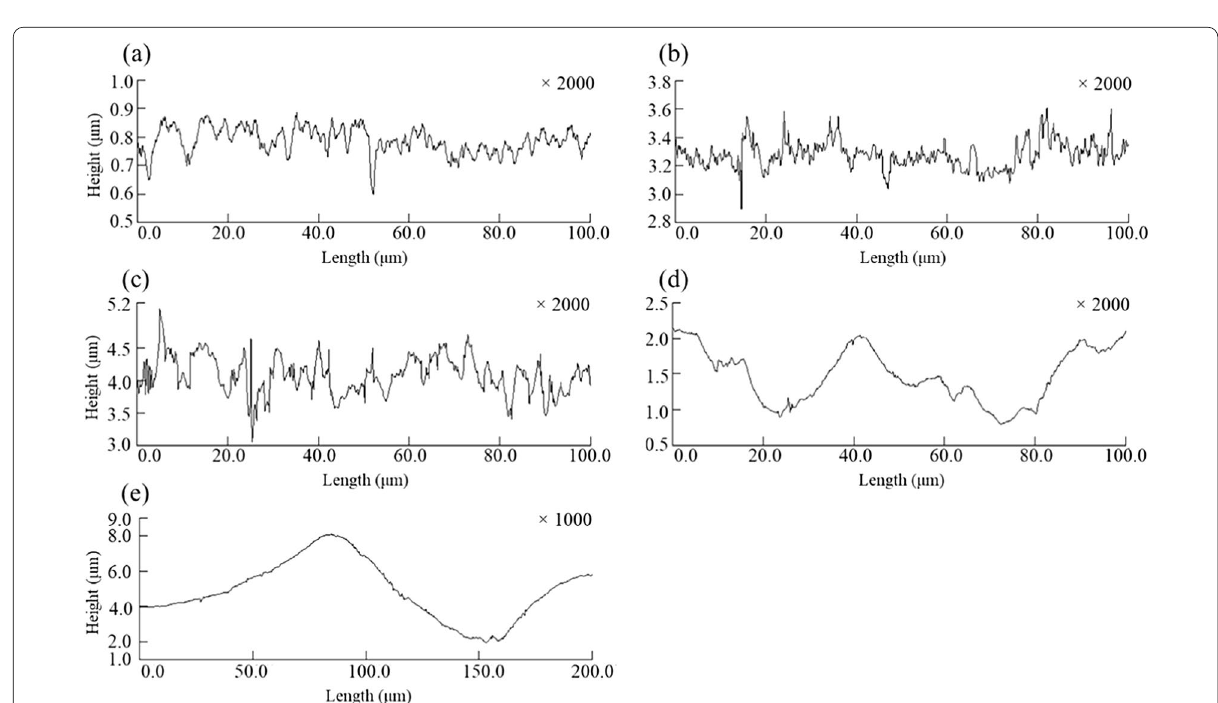
Fig. 2 Cross-sectional profile curves of control and FPB-treated surfaces. a Control, b FPB-1, c FPB-2, d FPB-3, and e